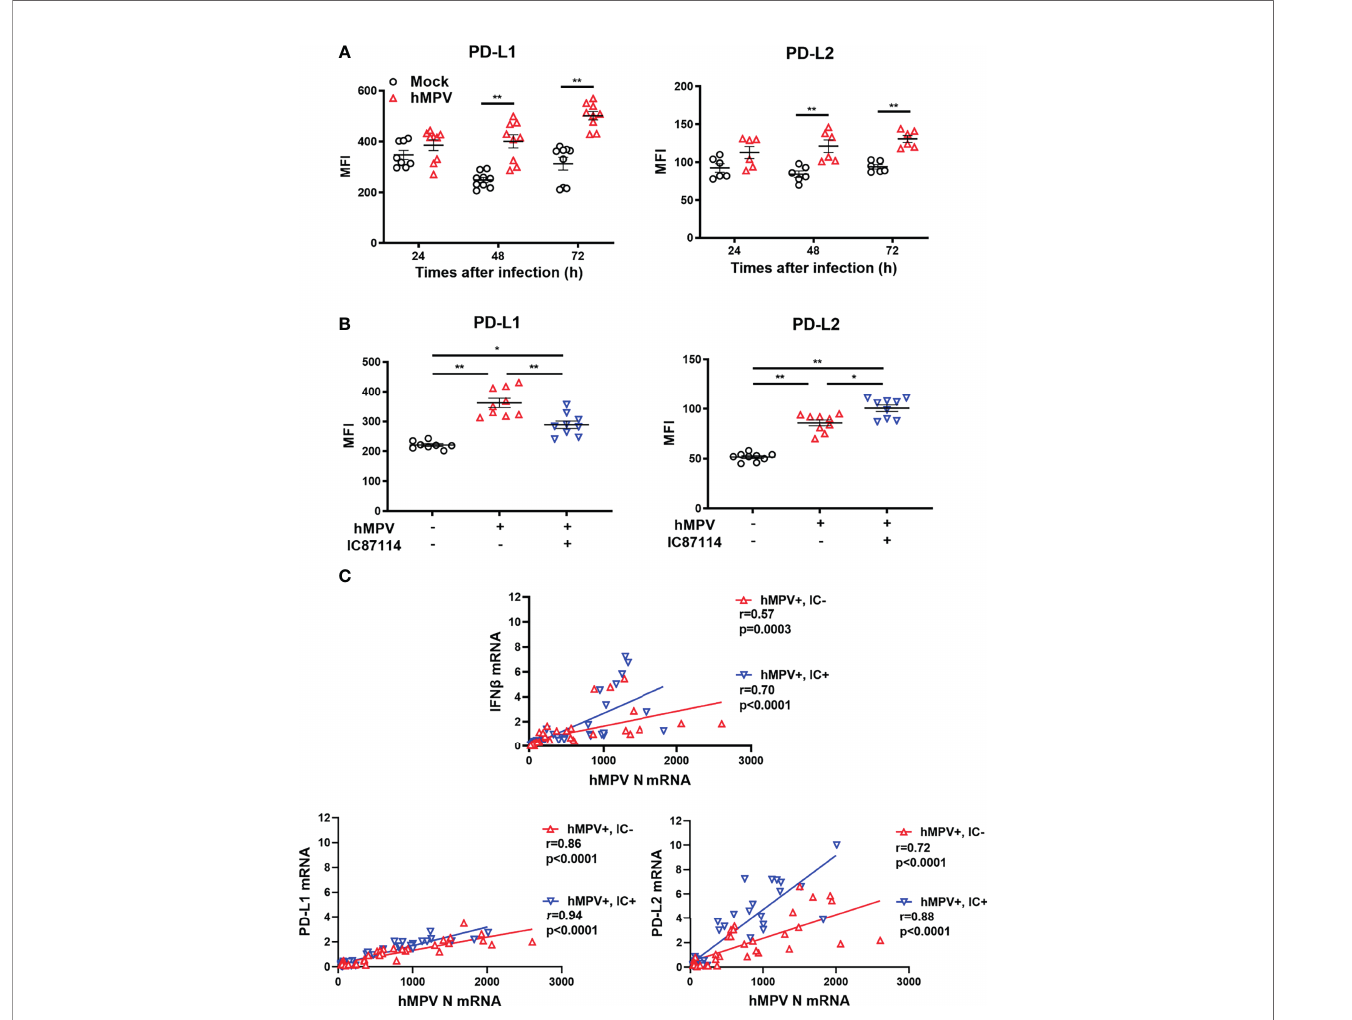
FIGURE 8 | A PI3K d inhibitor alters hMPV-induced gene and protein expression levels of PD-L1 and PD-L2 in PBECs. (A) PBECs were infected with hMPV (MOI 0.1), and PD-L1 and PD-L2 expressions were analyzed at the indicated times using fl ow cytometry. (B, C) IC87114 (10 m M) or vehicle was added prior to and after hMPV infection (MOI 0.1). (B) PD-L1 and PD-L2 expressions were analyzed at 48 h post-infection using fl ow cytometry. MFI, mean fl uorescence intensity. (C) Correlation between the gene expression of hMPV nucleocapsid protein (hMPV N) and IFN b , PD-L1, and PD-L2 mRNAs. Cell lysates for RNA extraction were collected at 24, 36, and 48 h post-infection. Gene expressions were measured by real-time quantitative reverse-transcription PCR and normalized to that of 18S rRNA. Data represent means ± SEM (n=6 – 12 per group) and pooled from a minimum of two independent donors with three replicates. * p <0.01, ** p <0.001 by one- or two-way ANOVA and Spearman correlation as appropriate. MFI, mean fl uorescence